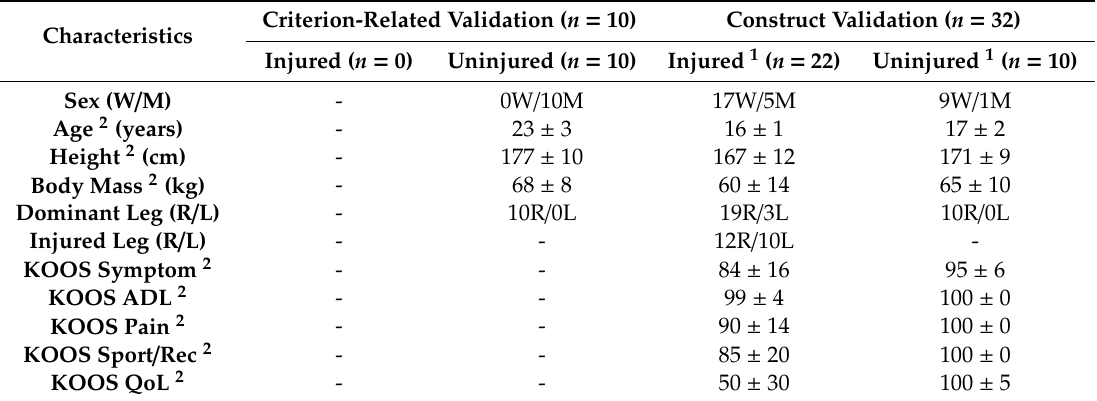
Table 1. Characteristics of the participants enrolled in the criterion-related validation and construct validation studies. For the participants of the construct validation study, self-reported Knee Injury and Osteoarthritis Outcome Score (KOOS) scores are also presented. The abbreviations used in the table are as follows: n: Number of participants; W: Woman; M: Man; R: Right; L: Left; ADL: KOOS subscale for Function in Daily Living; Sport / Rec: KOOS subscale for Function in Sports and Recreation; and QoL: KOOS subscale for Knee Related Quality of